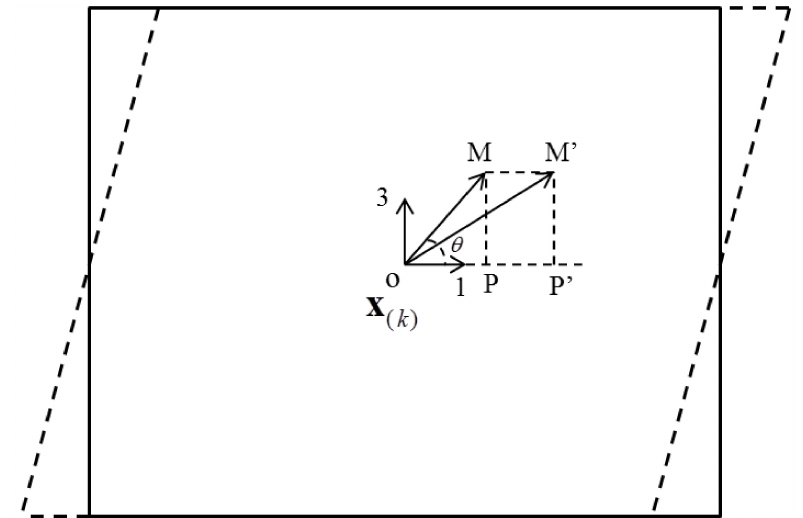
Figure A1. Pure shear loading on x–z plane ( γ 13